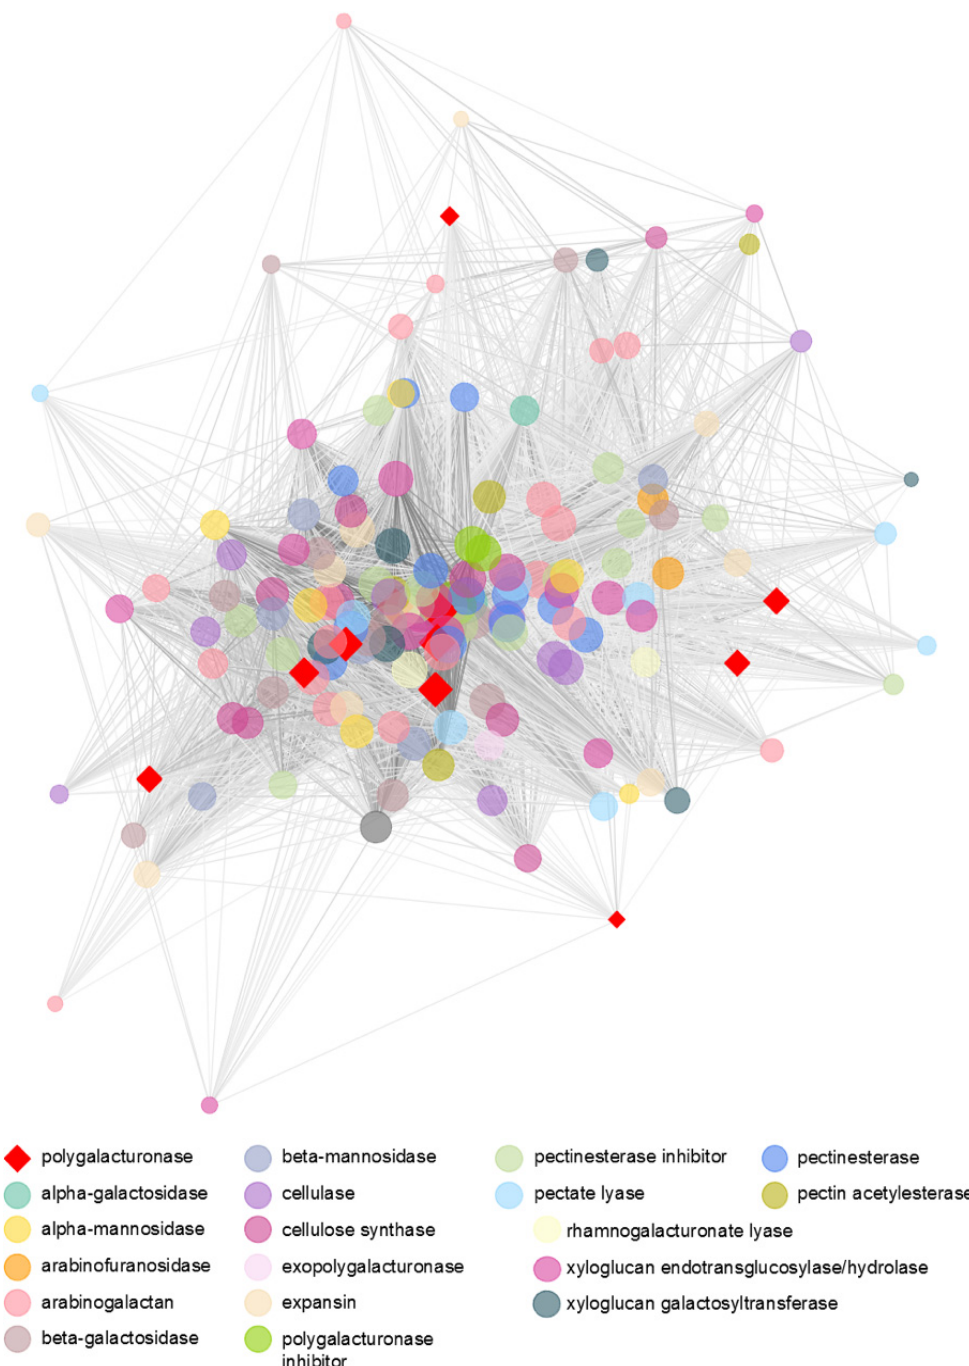
Figure 6. Co-expression correlation network of cell wall genes. Node sizes represent their connectivity degree. Edges vary in length and width, so the smaller and thicker an edge, the higher the correlation between the nodes.